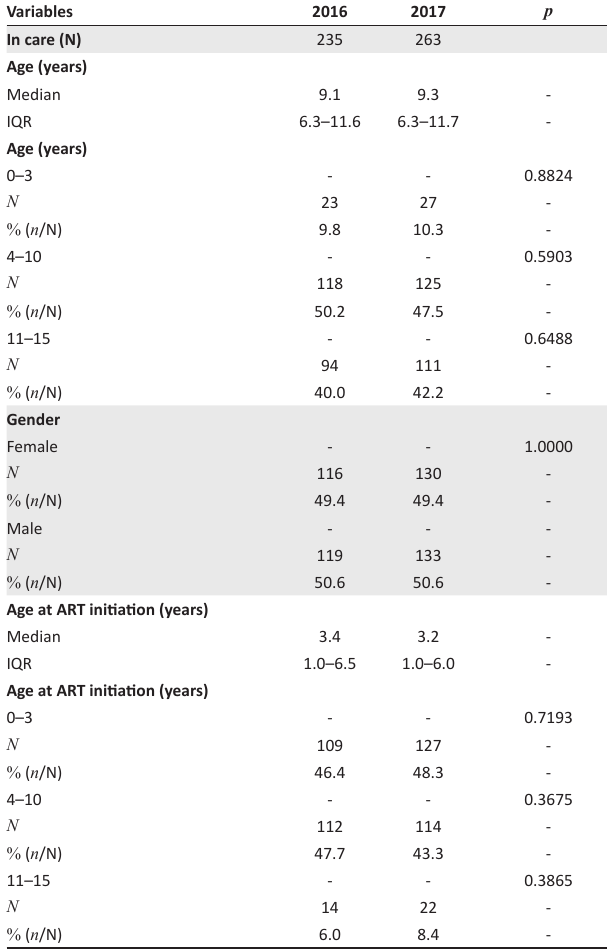
TABLE 1: Demographic data and baseline antiretroviral therapy